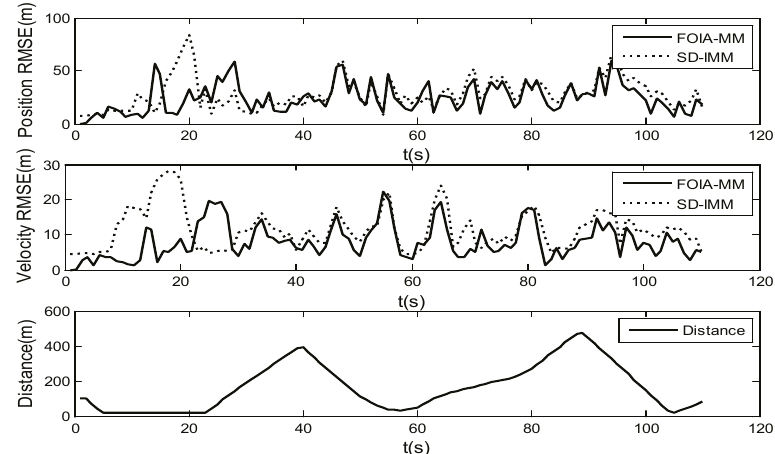
Figure 11. Root-mean-square error ( RMSE) of position (m) and velocity (m/s); ( σ (cid:2869) = 30𝑚 ), distance between the true position and the obstacle areas.